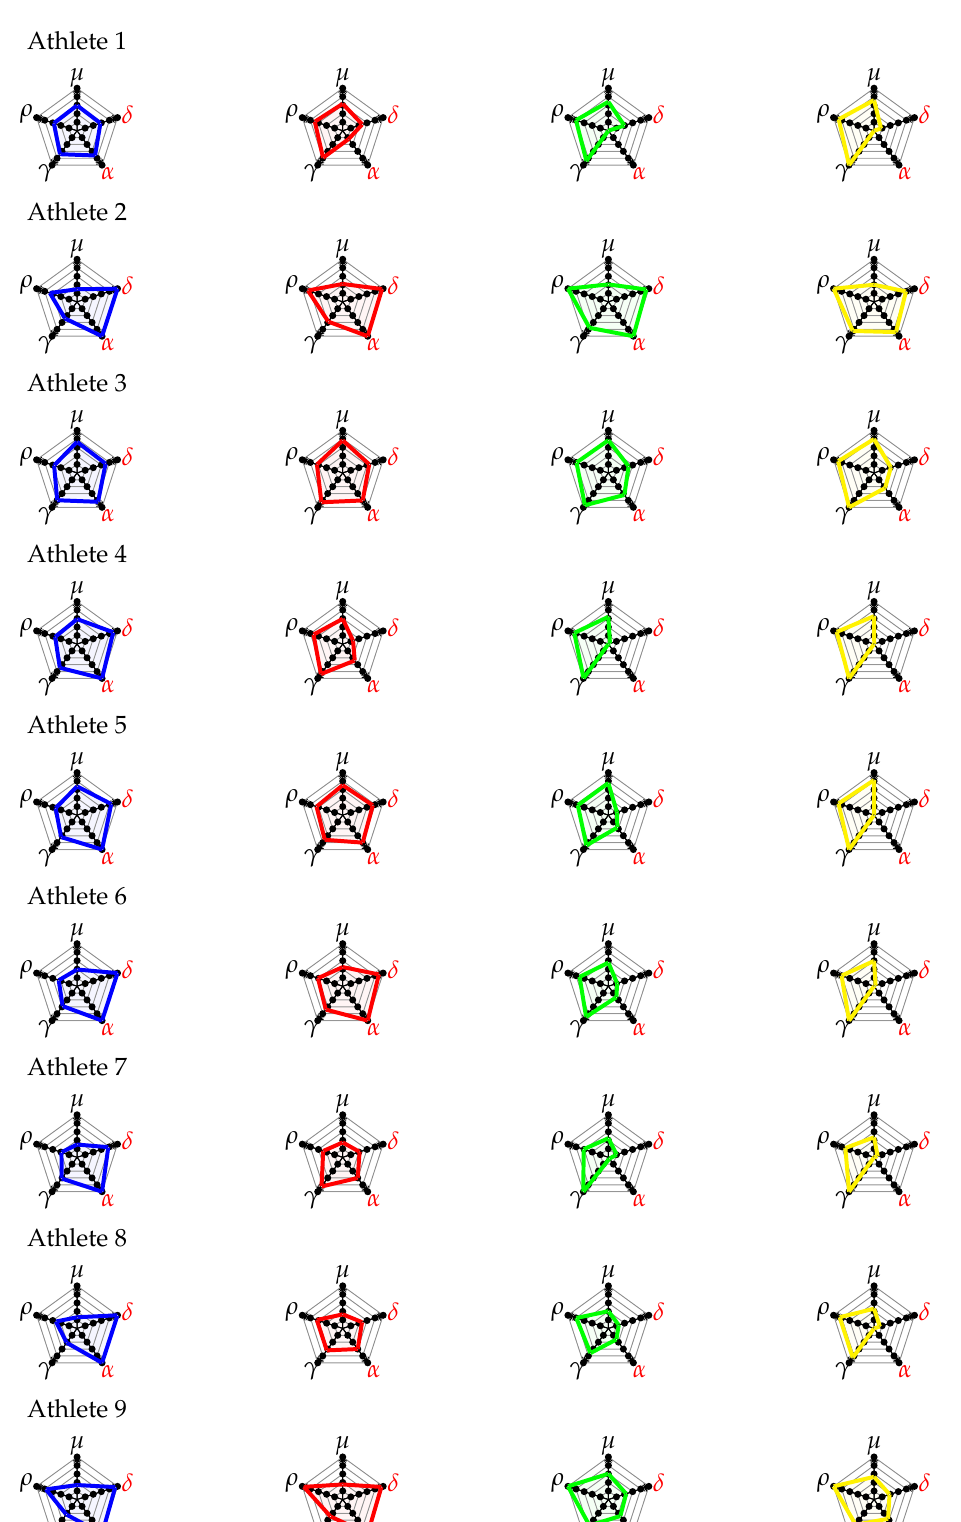
Figure 14. Radar charts for the experimental tests, for all the athletes involved in the study. The color lines graphically show the trend of the indices at different speeds (blue, 12.0 km/h; red, 13.0 km/h; green, 14.0 km/h; yellow, 14.5 km/h). The wider the area is, the better the gesture